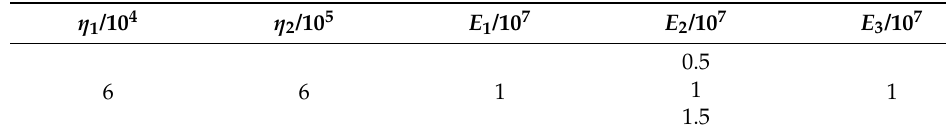
Table 5. E 2 as variable.